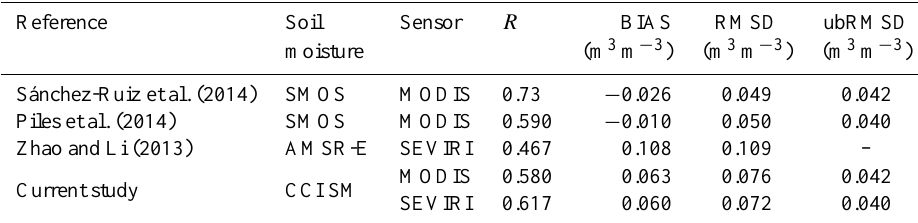
Table 4. Summary of the error statistics from other soil moisture downscaling studies also using REMEDHUS observations for validation. The statistics of the current study are from the comparison of station-averaged soil moisture. Reference